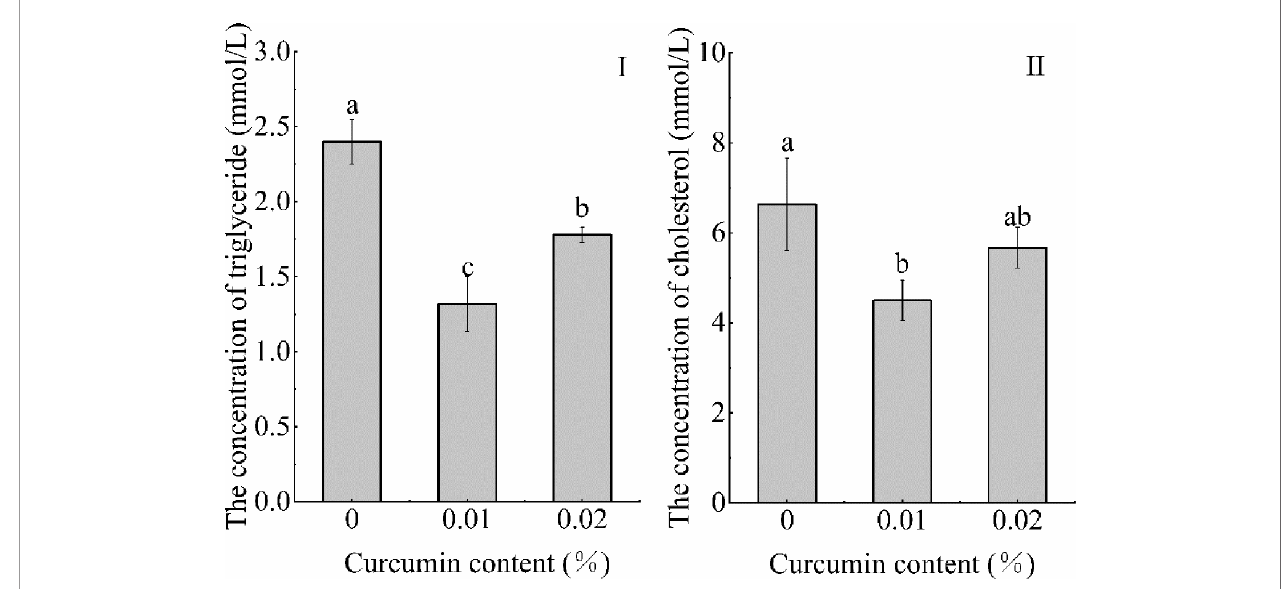
FIGURE 3 | Effects of different levels of curcumin on serum triglyceride and total cholesterol content of Seriola dumerili (I, triglyceride content; II, total cholesterol content). Different superscript letters indicate signi fi cant differences among treatments (P < 0.05).